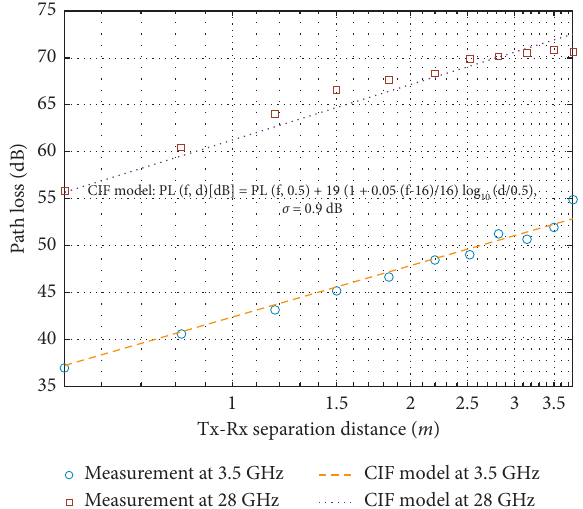
Figure 6: CIF path loss model for the measured data for both